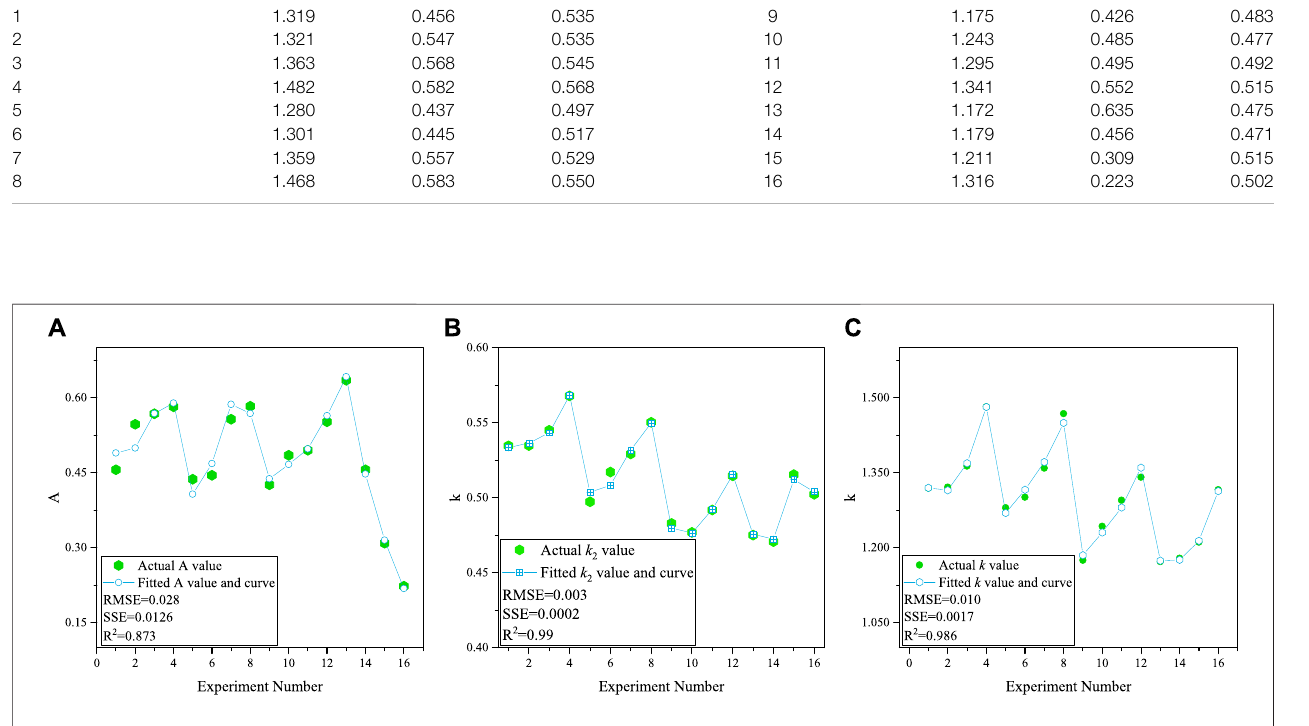
FIGURE 5 | Fitting curves of A, k , and k 2 . (A) Fitting curve of A ; (B) fi tting curve of k 2 ; and (C) fi tting curve of k .